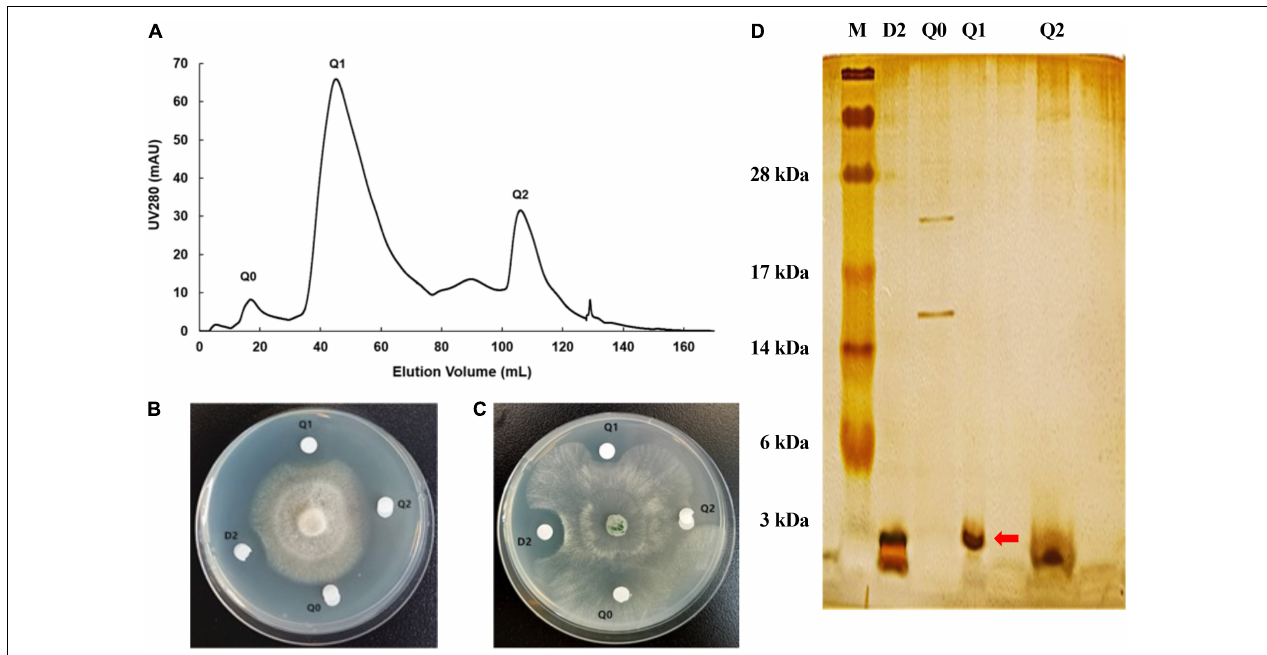
FIGURE 4 | Purification of antifungal protein by Q Sepharose Fast Flow column. (A) Chromatographic profile of D2 from DEAE separation on HiTrap Q Sepharose Fast Flow column using AKTA pure 25 system. (B) The antifungal activity of several fractions from component D2 against F. oxysporum. (C) The antifungal activity of several fractions from D2 against S. sclerotiorum . (D) 15% SDS-PAGE profile of several fractions from Q2. The red arrow shows the distinct protein band of component Q1.